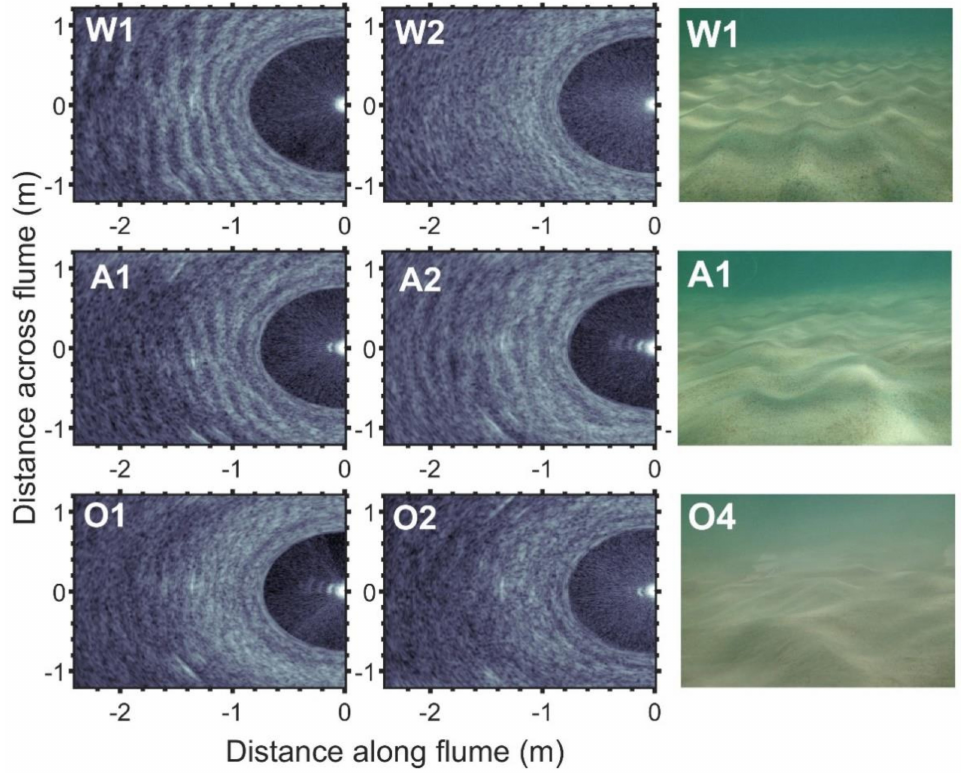
Figure 3. Plan view of bed morphology observed through SSS scans at the end of each test run, and underwater photographs of selected